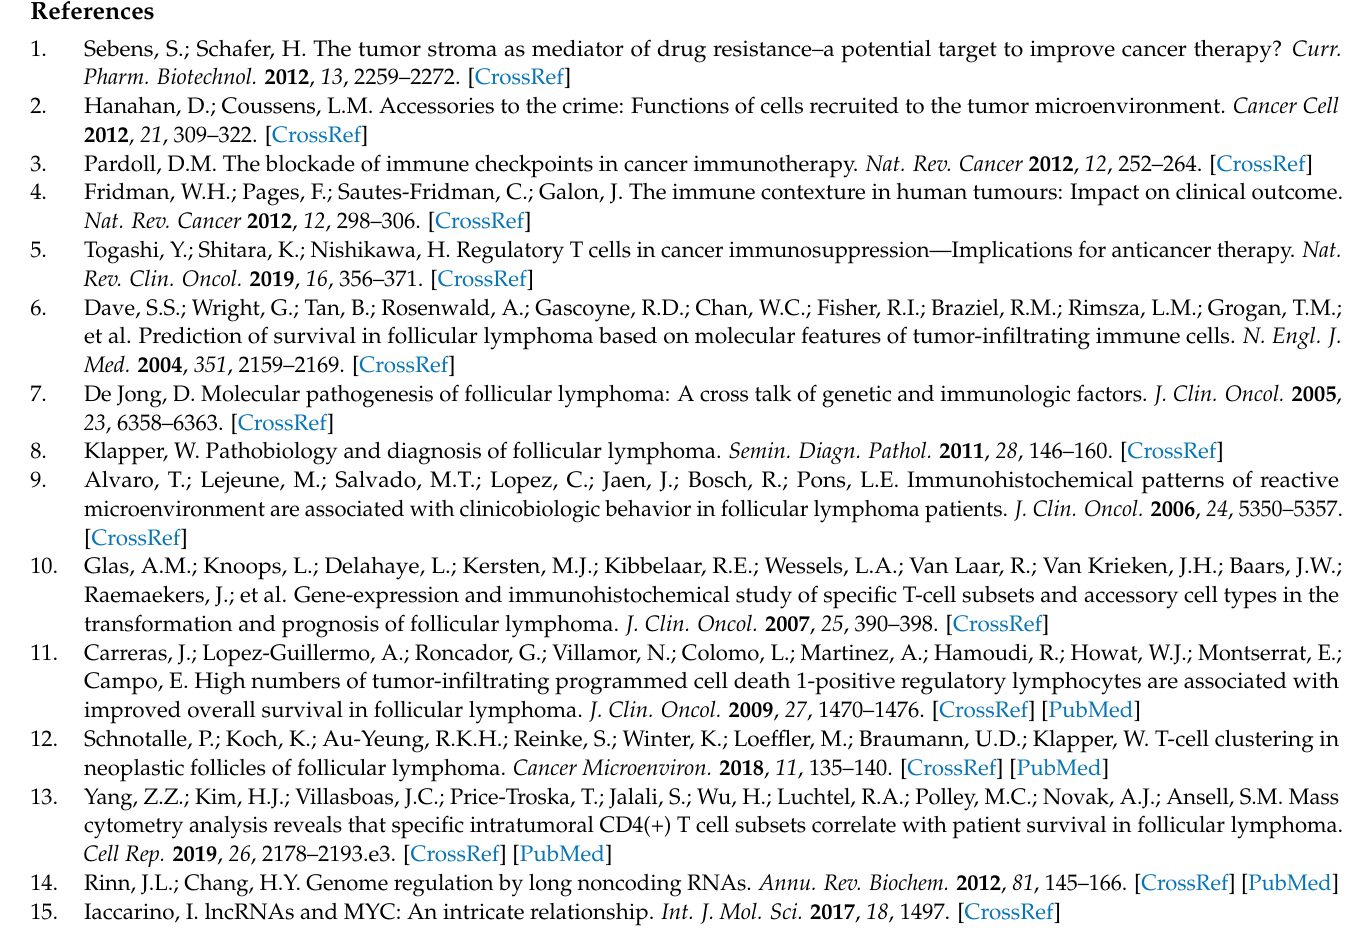
ples; Table S3: List of the genes with the strongest positive or negative expression correlation